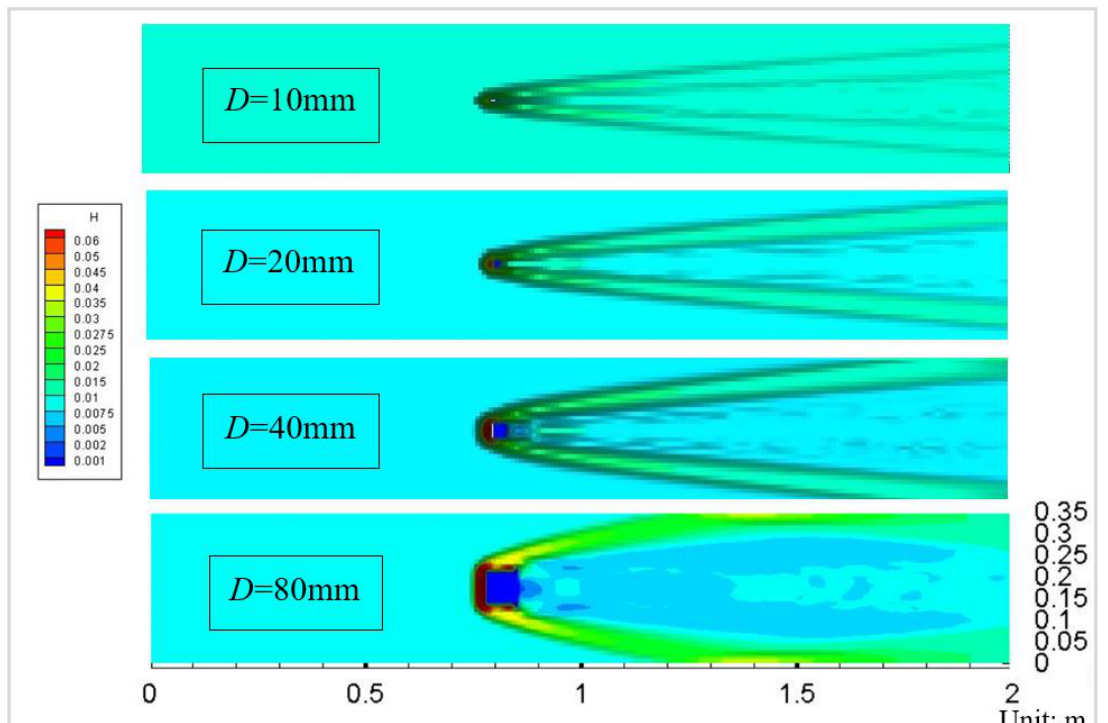
Figure 4. Configurations of an avalanche hitting an obstacle with different side lengths at time t = 4.5 s.